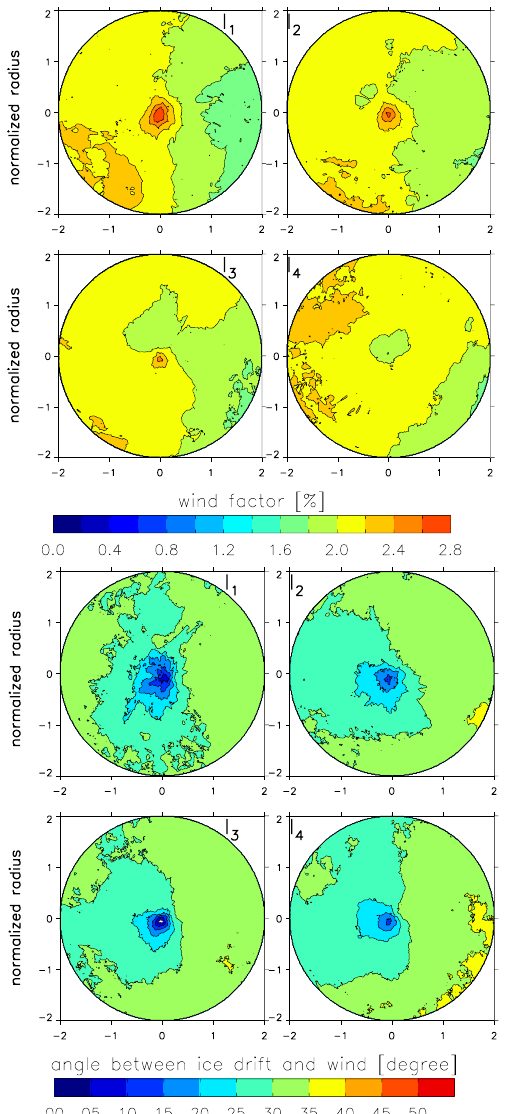
Fig. 5. Time series of wind (top), ice drift (middle), and wind factor (bottom) for different intensity classes. Shown are the mean values within the cyclone radius for the time period from 2days before to 5days after detection ( t =